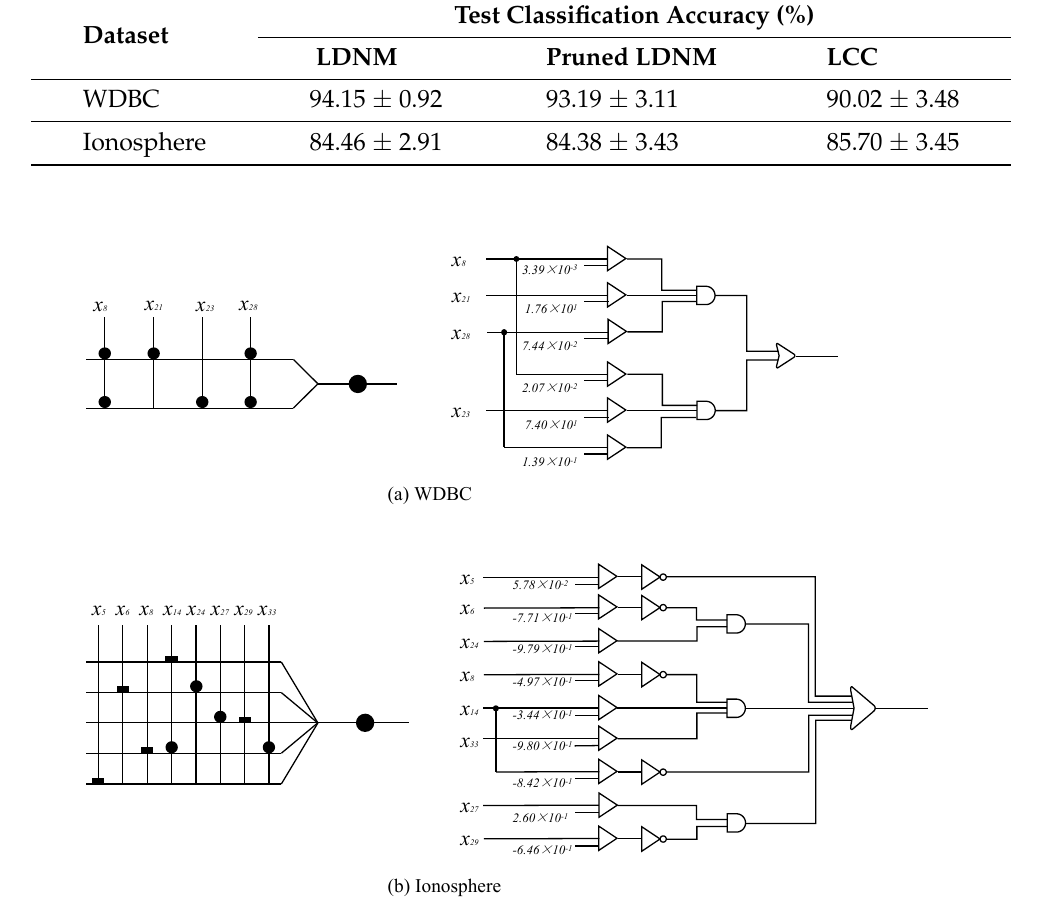
Figure 8. Two examples of a pruned LDNM and its corresponding LCC for two problems. Specifically, the thresholds of all comparators have reverted to the original values (before